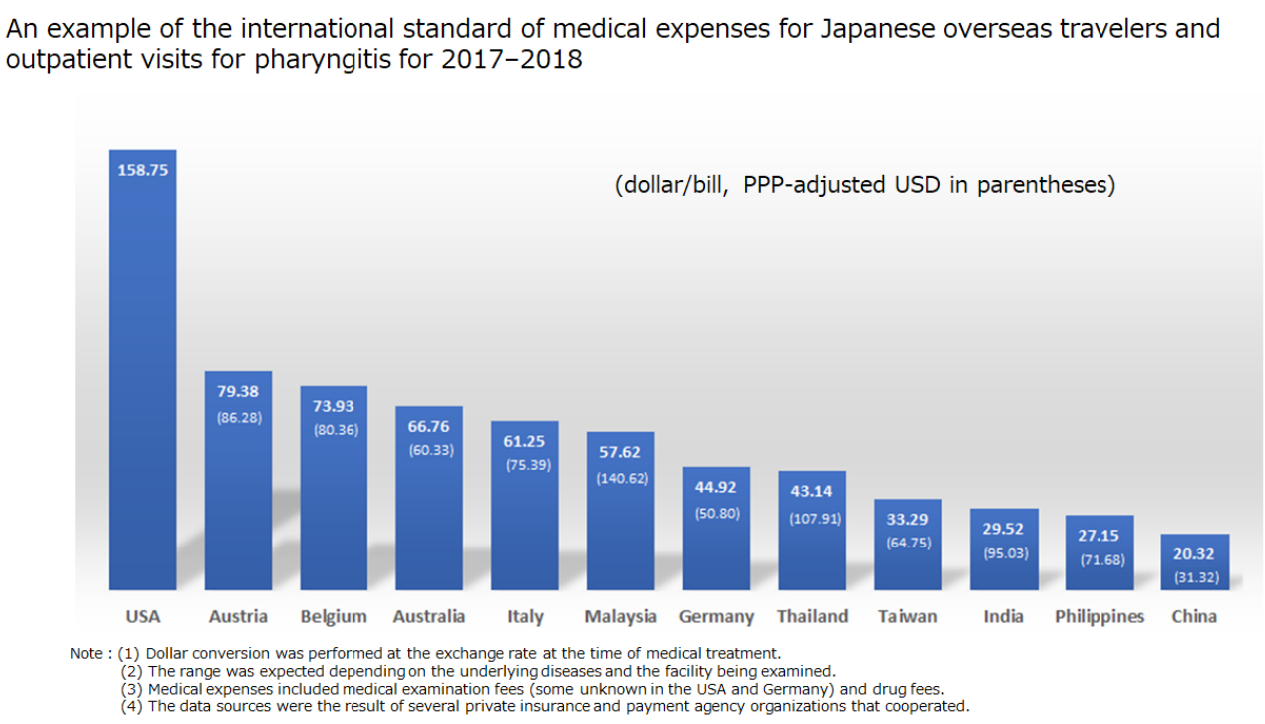
Figure 5. International comparison of medical expenses (pharyngitis and outpatient).